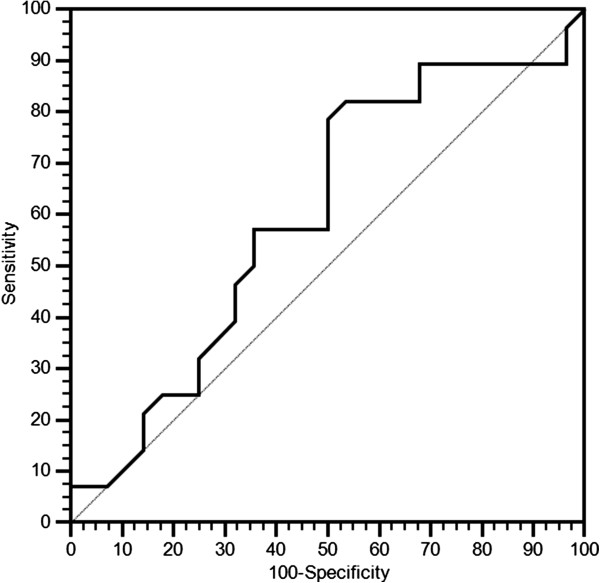
ROC curve for OS.